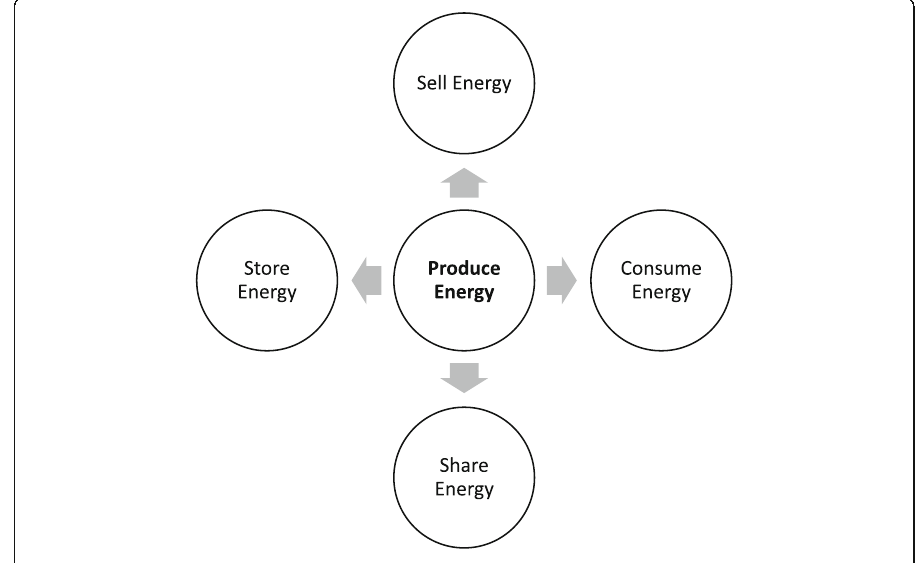
Fig. 1 The role of a prosumers in community